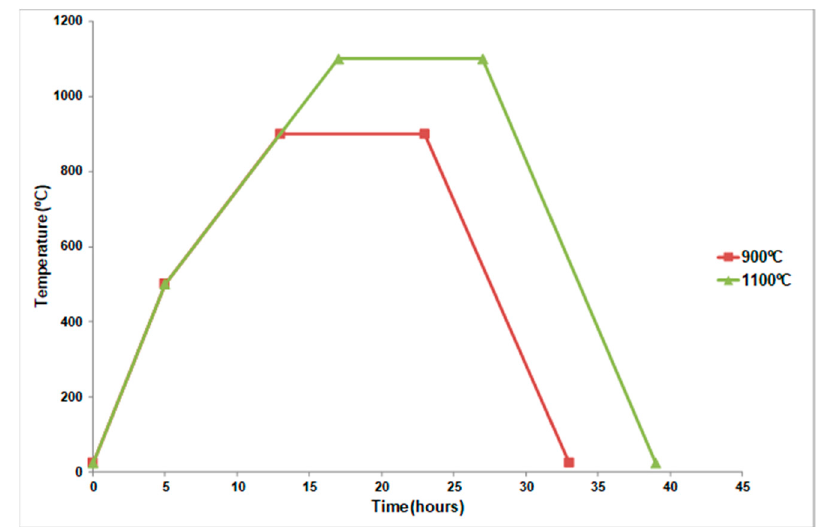
Figure 1. Brick heating